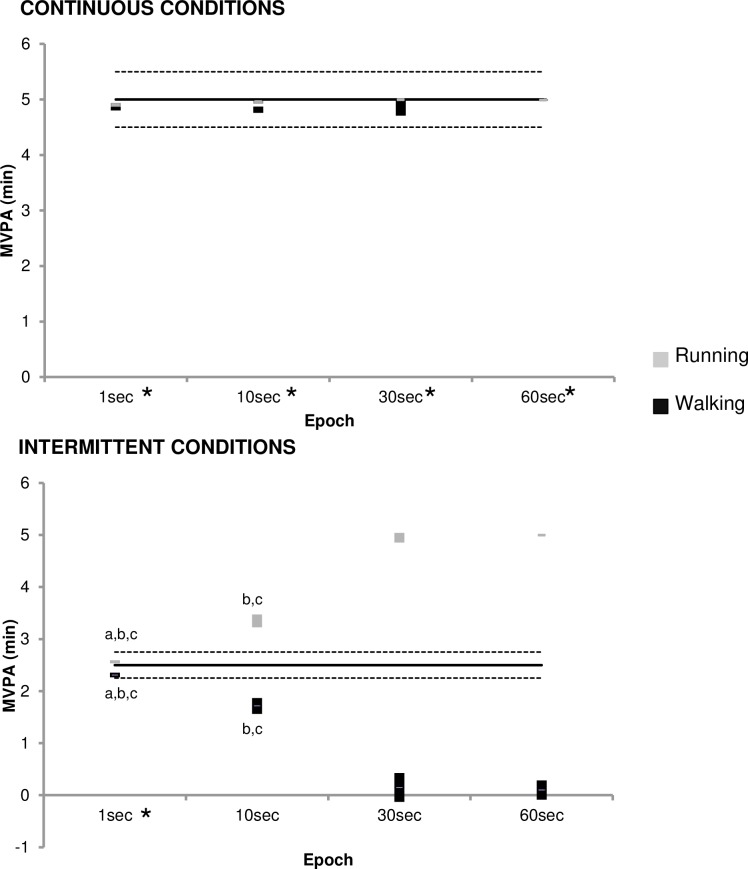
Results from 95% equivalence testing for agreement in time MVPA according to the different epoch lengths selected.Upper and lower panels represent data from the continuous and intermittent conditions, respectively. Dark lines represent the reference values (i.e., 5-min for continuous conditions and 2.5-min for intermittent conditions) and the dotted lines indicate the equivalence zone (±10% of the reference value); Grey and dark bars represent the 90% confidence interval for the mean MVPA value obtained with the corresponding epoch. * Within the equivalence zone. a Significantly different from the 10-sec epoch with p<0,001. b Significantly different from the 30-sec epoch with p<0,001. c Significantly different from the 60-sec epoch with p<0,001.